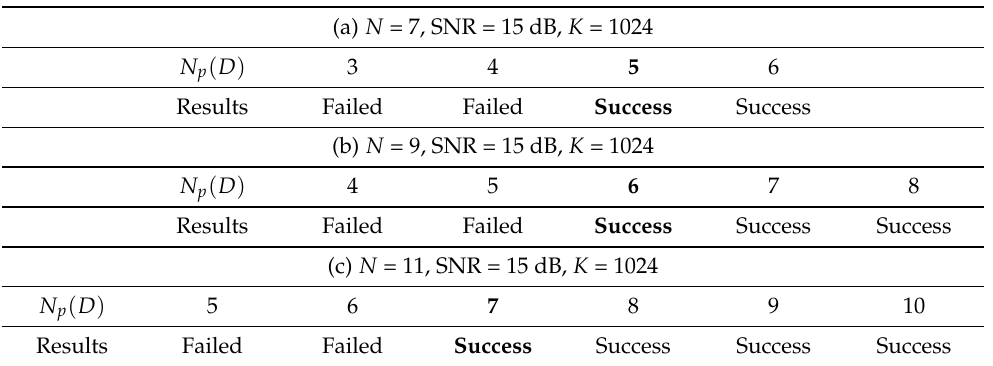
Table 2. Simulation Results of Various ( N , N p ) .